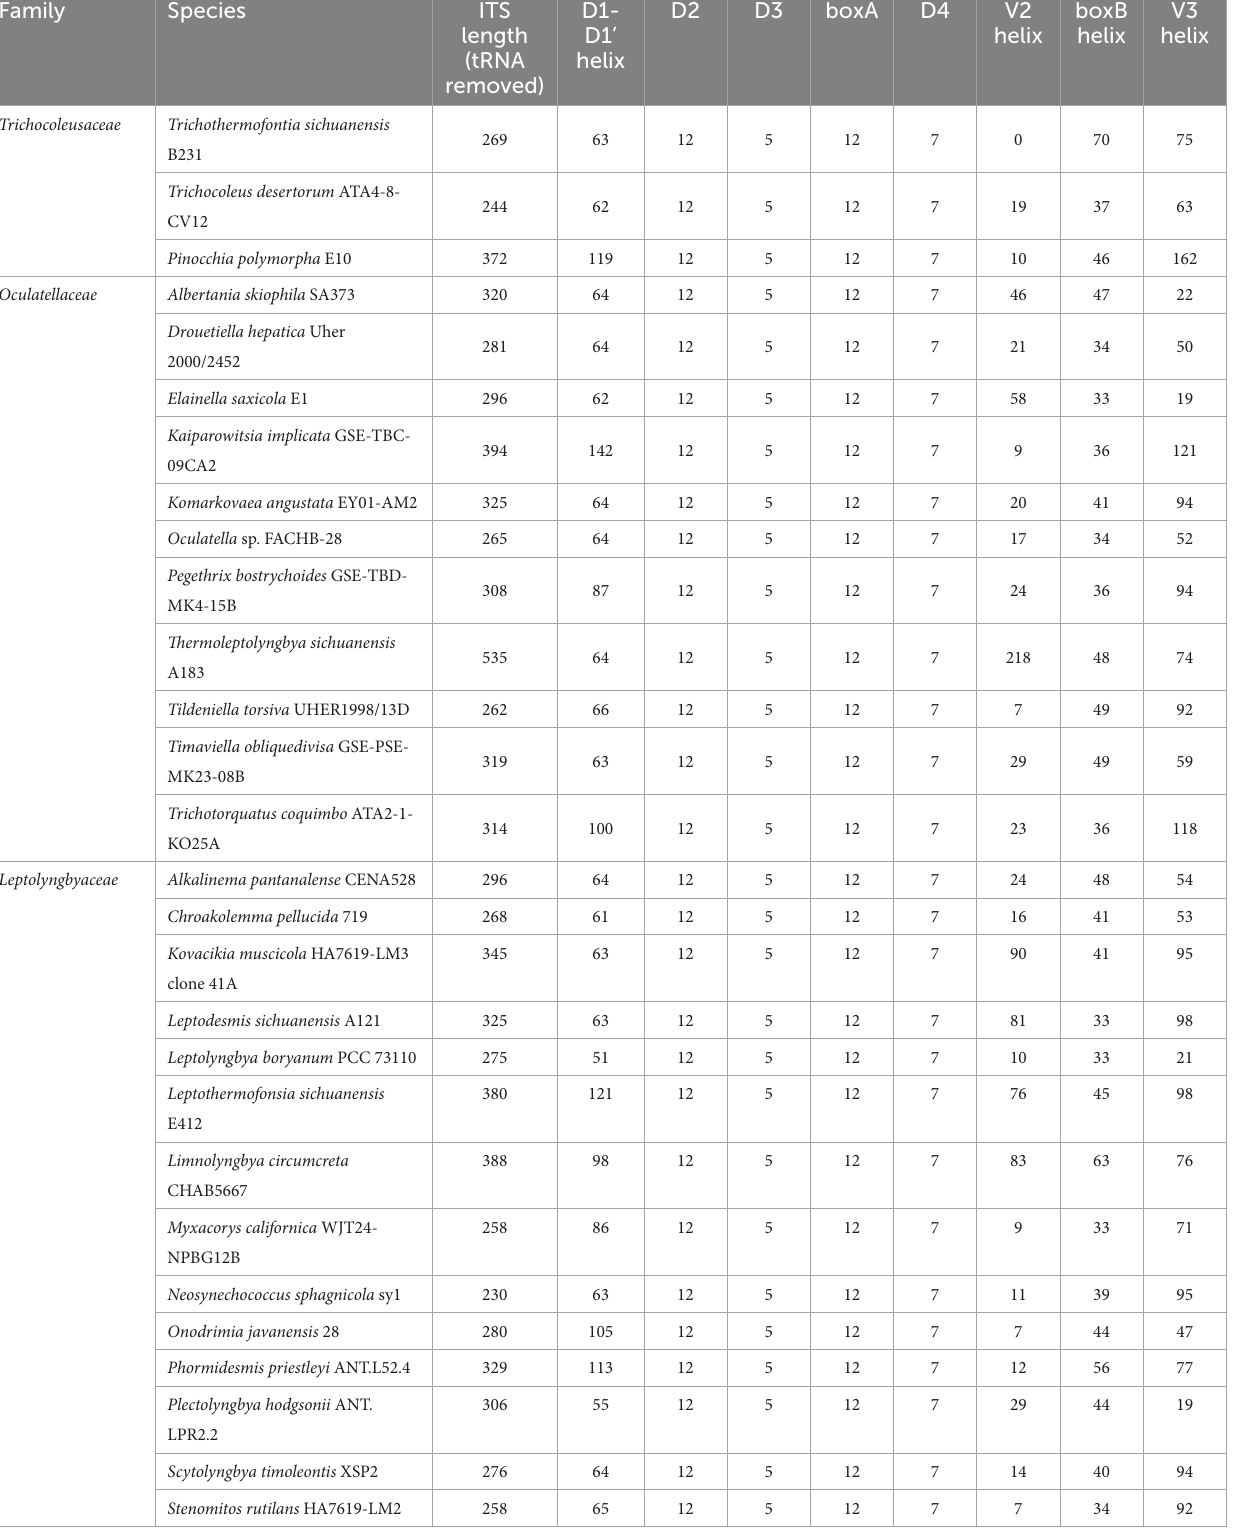
TABLE 3 The Length summary (bp) of corresponding regions within 16S-23S ITS of strain B231 and focal taxa. Family Species ITS